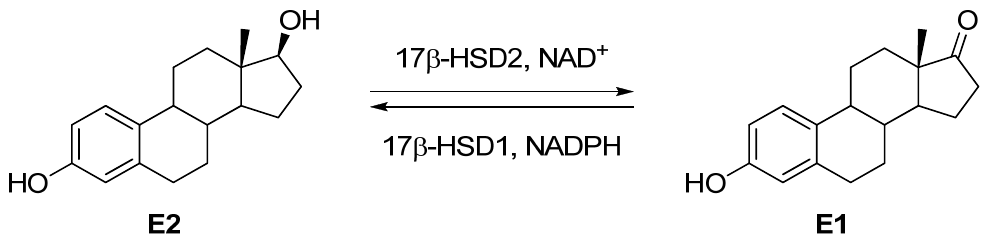
Figure 1. Interconversion of Estradiol (E2) to Estrone (E1) by 17  -HSD2 and 17 